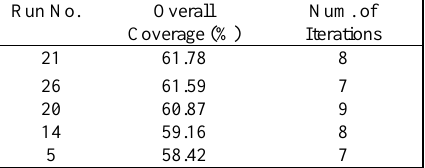
Table 2: Results of 5 best runs for Context-Aware